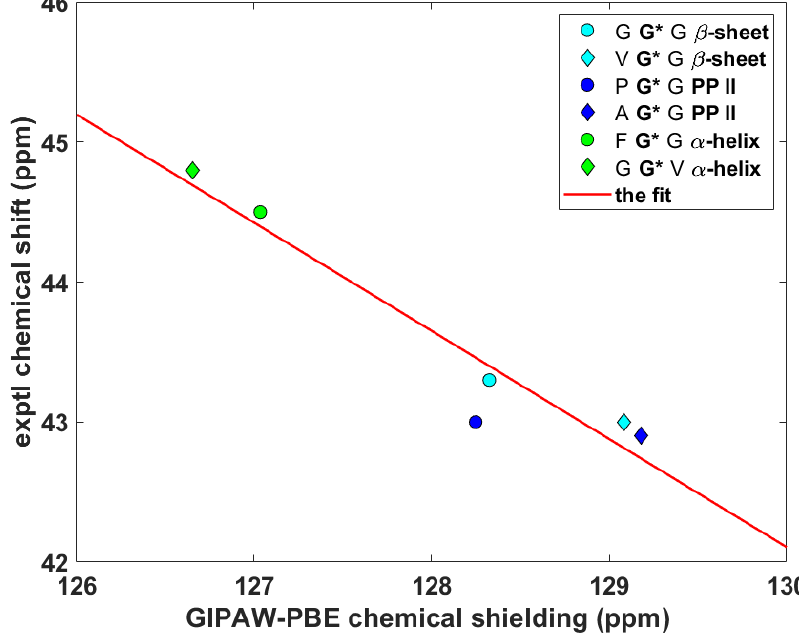
Figure 2. The isotropic 13 C data of C α nuclei of selected glycyls in tripeptides.